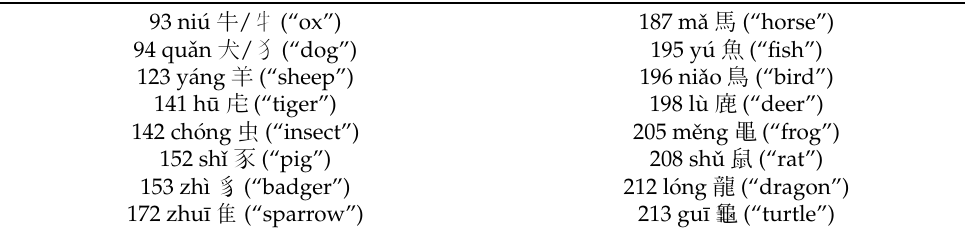
Table 1. “Animal Radicals” Utilized in Chinese